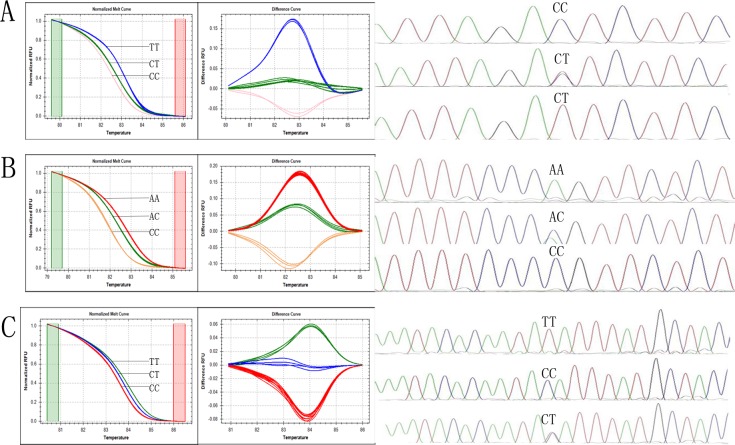
High resolution melting curves and sequencing pattern for different genotypes of three SNPs.A: rs1212171, B: rs1187323, C: rs1778929. SNPs were determined through HRM curves using the sequenced samples as control genotypes. The studied SNPs were successfully genotyped by HRM analysis, which shown in the left,and the right is sequencing pattern. The results obtained from the DNA sequencing analysis confirmed the reliability of the HRM assay.